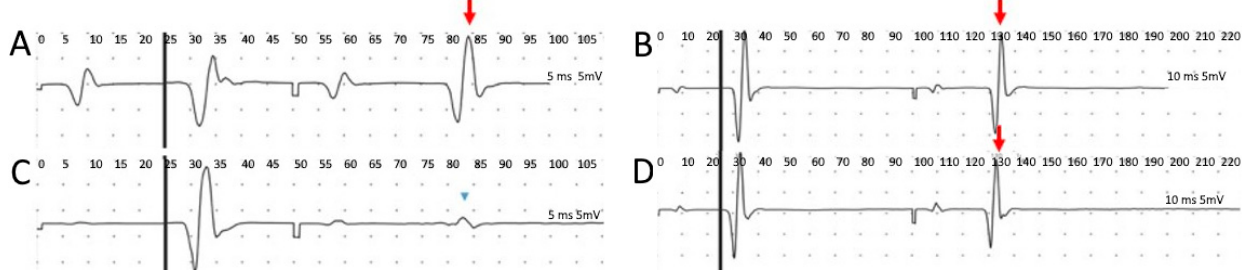
Figure 1. The patient 1 recovery curves of H-reflex obtained by delivering paired stimulus at interstimulus intervals (ISI) of 50 ms and 100 ms, respectively, pre ( A , B ) and post ( C , D ) TsMS inhibitory protocol. Note that in figure ( A ), before inhibitory modulation with TsMS, the conditioned H-reflex was present and with high amplitude at ISI of 50 ms (arrow). This provides neurophysiological evidence of neuronal hyperexcitability in this patient. After the TsMS inhibitory protocol, the conditioned H-reflex at 50 ms was almost completely inhibited (arrow head) ( C ). There was no evident difference in conditioned H-reflex with ISI of 100 ms before ( B ) and after ( D ) neuromodulation (arrow).